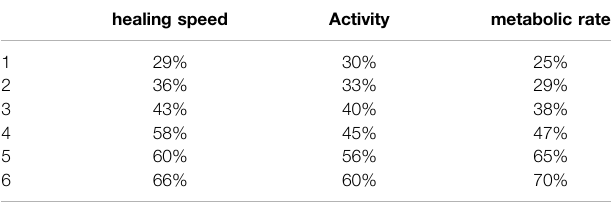
TABLE 3 | Restoration state of meniscus in group B of specimens at 6 weeks. healing speed